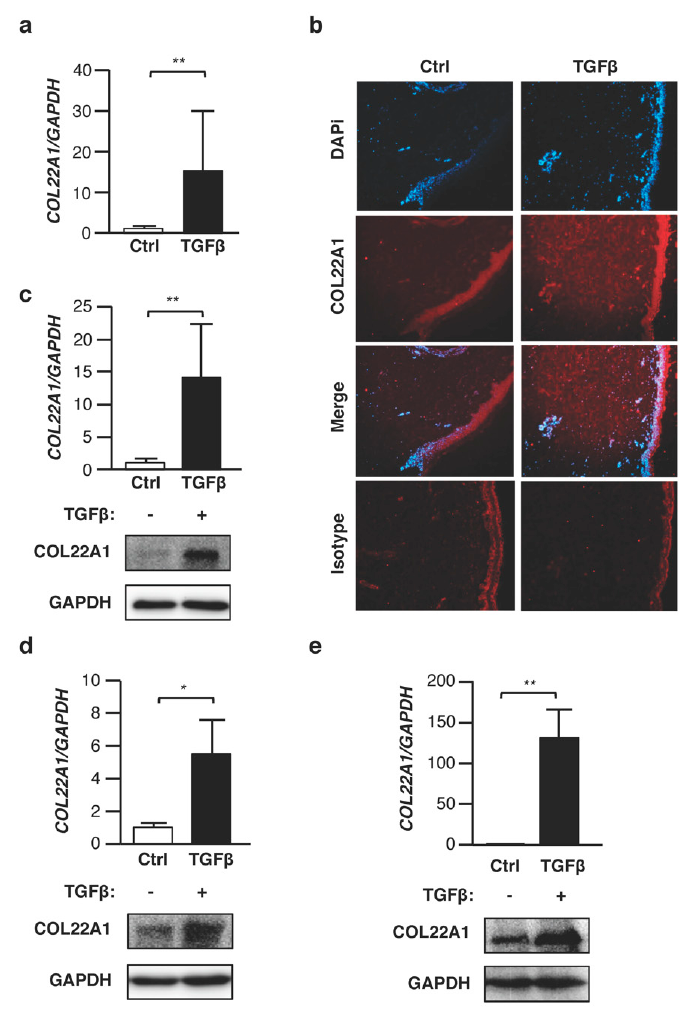
Figure 1. TGF β increases expression levels of COL22A1 ex vivo and in vitro. ( a , b ) Human skin samples were treated with TGF β (10 ng/mL) for 48 and 72 h. ( a ) Expression levels of COL22A1 were measured in human skin (N = 5); ** p < 0.01. ( b ) Localization of COL22A1 in ex vivo normal skin. COL22A1 was detected using immunofluorescence in a vehicle control or TGF β -treated skin tissue. DAPI was used to detect nuclei (original magnification × 40); scale bars = 100 µ m. ( c ) Human normal skin fibroblasts were treated with TGF β (5 ng/mL) for 24 or 72 h. Expression levels of COL22A1 mRNA were measured in human normal skin fibroblasts (N = 9); ** p < 0.01. Protein levels of COL22A1 in the skin fibroblasts of three healthy donors were analyzed by immunoblotting of the lysates; GAPDH is shown as a loading control. ( d ) Human normal lung fibroblasts were treated with TGF β (10 ng/mL) for 48 or 72 h. Expression levels of COL22A1 mRNA were measured in human normal lung fibroblasts treated with a vehicle control or TGF β (N = 3); * p < 0.05. The protein levels of COL22A1 in lung fibroblasts were analyzed by immunoblotting of the lysates. ( e ) A549 cells were treated with TGF β (5 ng/mL) for 24 or 72 h. Expression levels of COL22A1 mRNA were measured in A549 cells treated with a vehicle control or TGF β (N = 3); ** p < 0.01. Protein levels of COL22A1 in the A549 cells were analyzed by immunoblotting of the lysates.